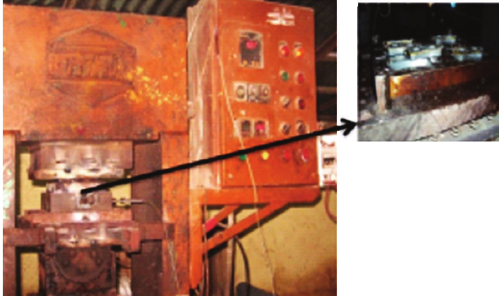
Figure 4: Curing apparatus.